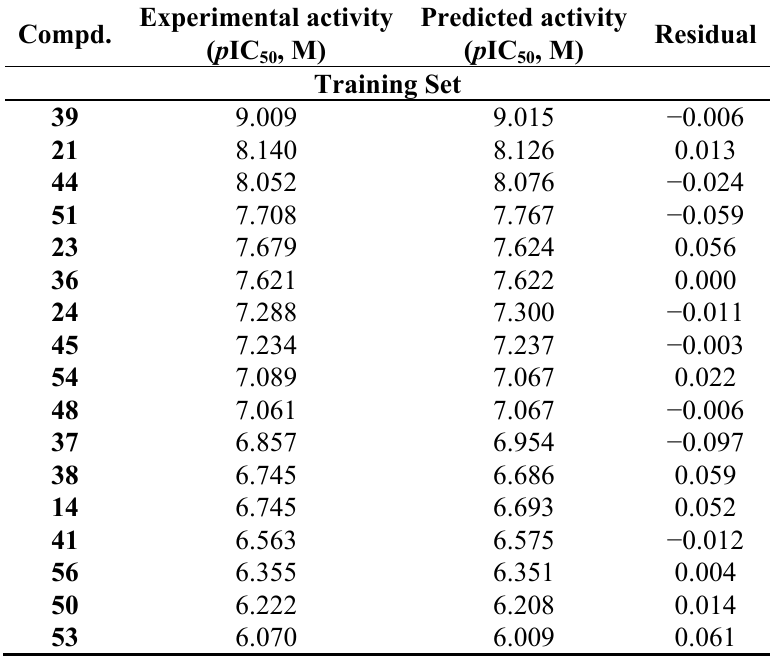
Table 3. Experimental and predicted activity for training and test